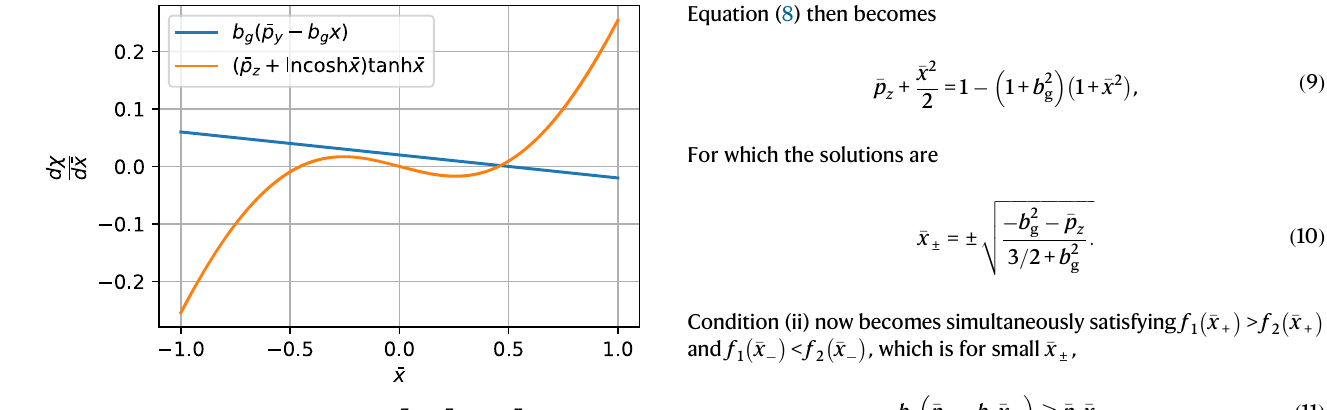
Fig. 8 | Two functions that contribute to d χ = b g =0.2. Plots of functions f 1